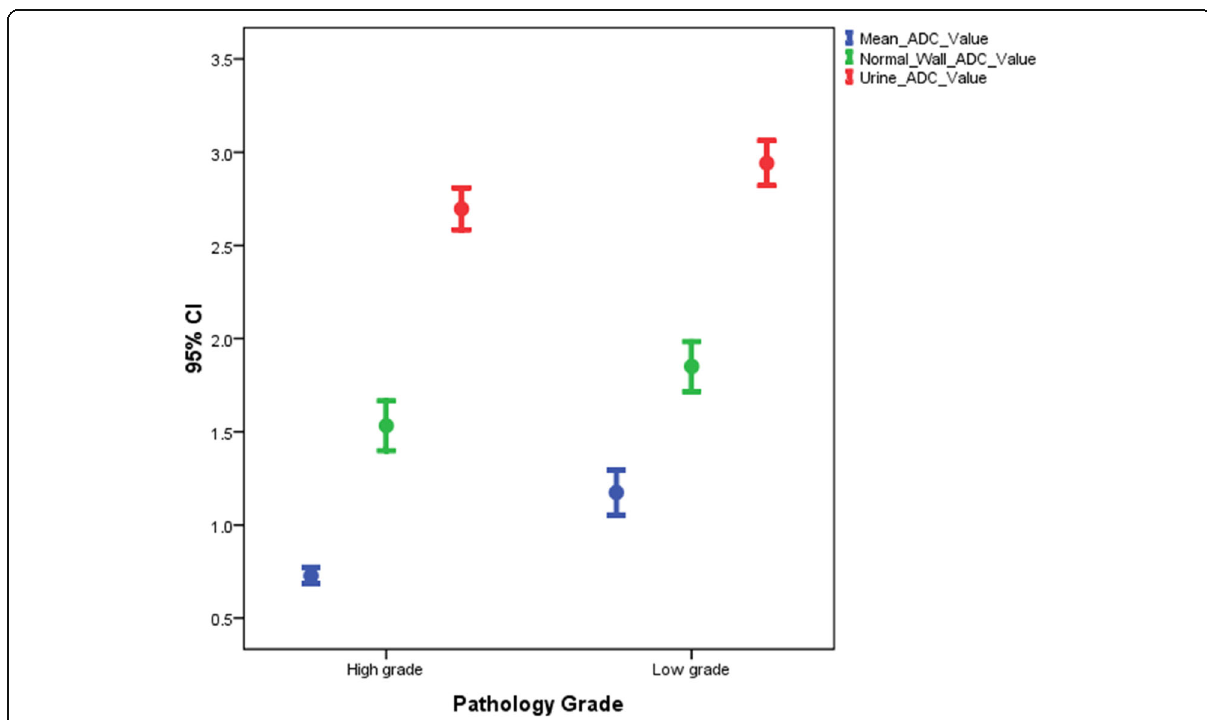
Fig. 2 Mean ADC values according to tumor